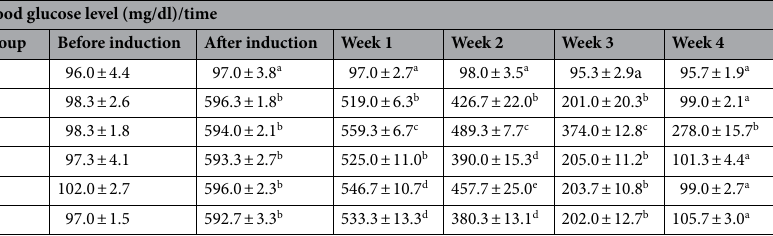
Table 10. Effect of P. americana extracts on the blood glucose level of the alloxan-diabetic rats. Values represent mean ± standard deviation (n = 5). Values with different superscripts (a,b,c,d,e) along the same column are significantly different from one another (P < 0.05). Group I—normal control rats, Group II—diabetic rats treated with Glibenclamide, Group III—diabetic rats not treated, Group IV—diabetic rats treated with methanol extract of P. americana bark, Group V—diabetic rats treated with methanol extract of P. americana root, Group VI—diabetic rats treated with methanol extract of P. americana